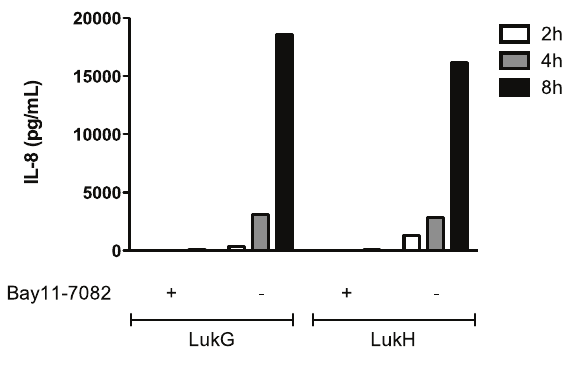
Figure 9. LukG and LukH induction of IL-8 production by PMNs pretreated with an inhibitor of NF k B. PMNs (2 6 10 6 /mL) were pretreated with Bay11-7082 (50 m M) for 1 h and then mixed with 500 nM LukG or LukH for 2–8 h. IL-8 levels in the supernatants were measured by ELISA.